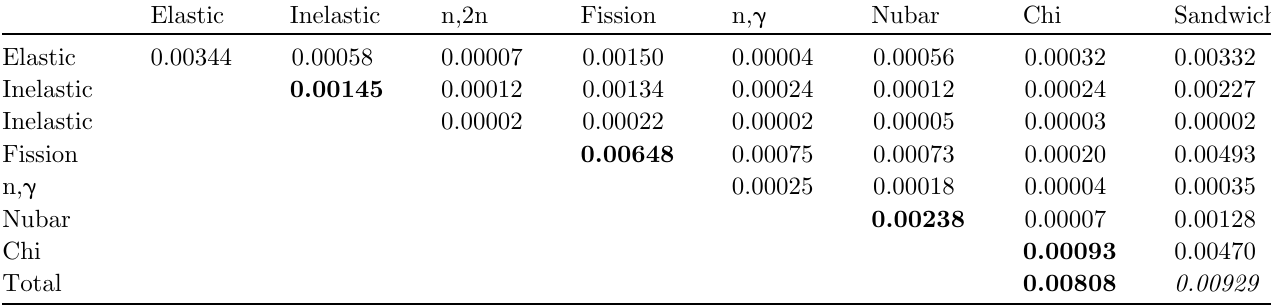
Table 3. Forwards HMM (TALYS) uncertainty propagation results.